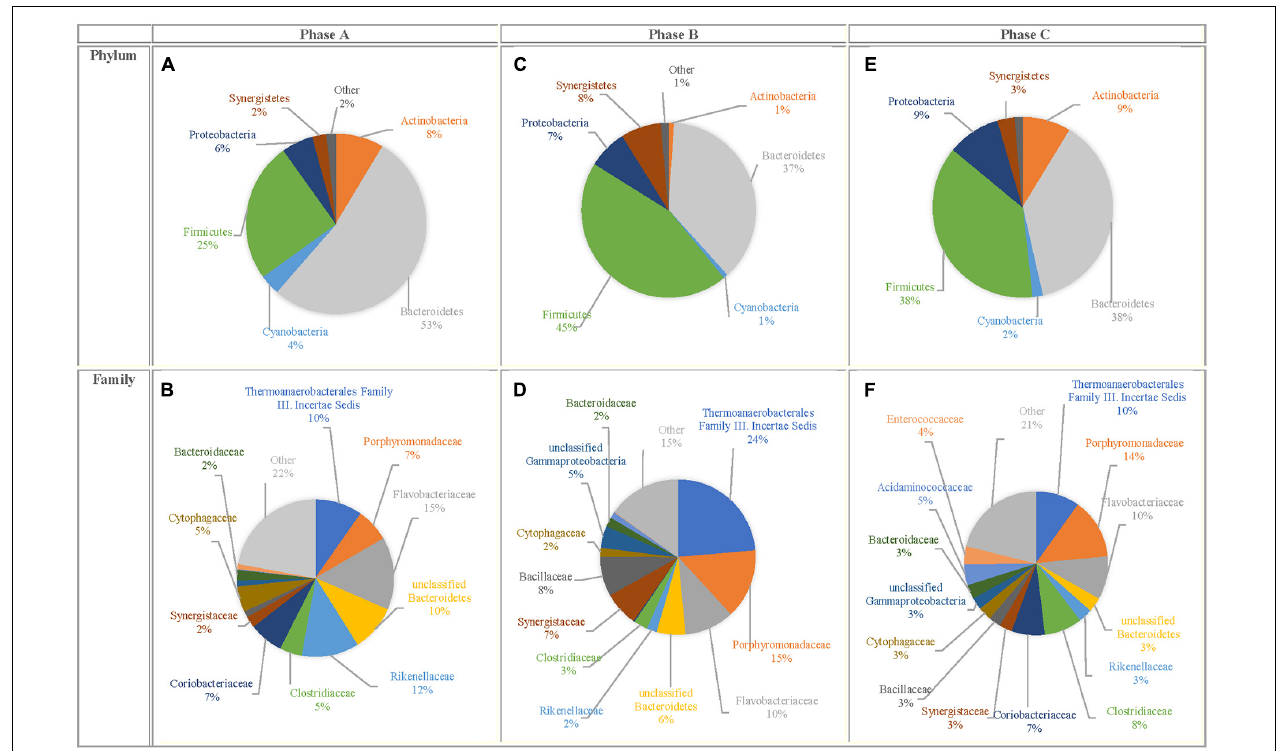
FIGURE 3 | Bacterial community profile for Phase A, Phase B, and Phase C for phylum level (A,C,E) and family level (B,D,F) .